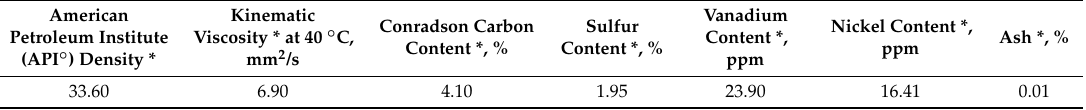
Table 3. Physical and chemical characteristics of the crude oil used for the JETs.